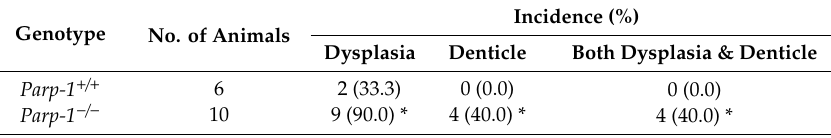
Table 2. Incidence of dental dysplasia of aged C57BL / 6